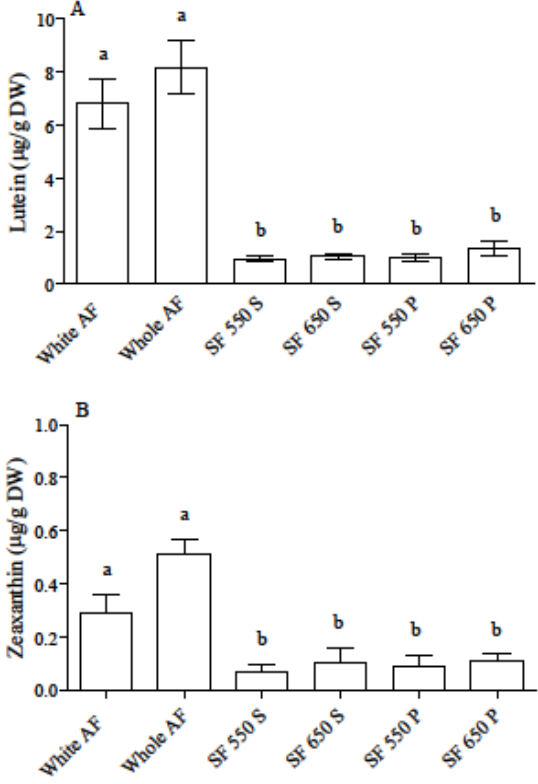
Figure 1. Lutein ( A ) and zeaxanthin ( B ) content in AF and SF samples. Results are the mean ± SD of